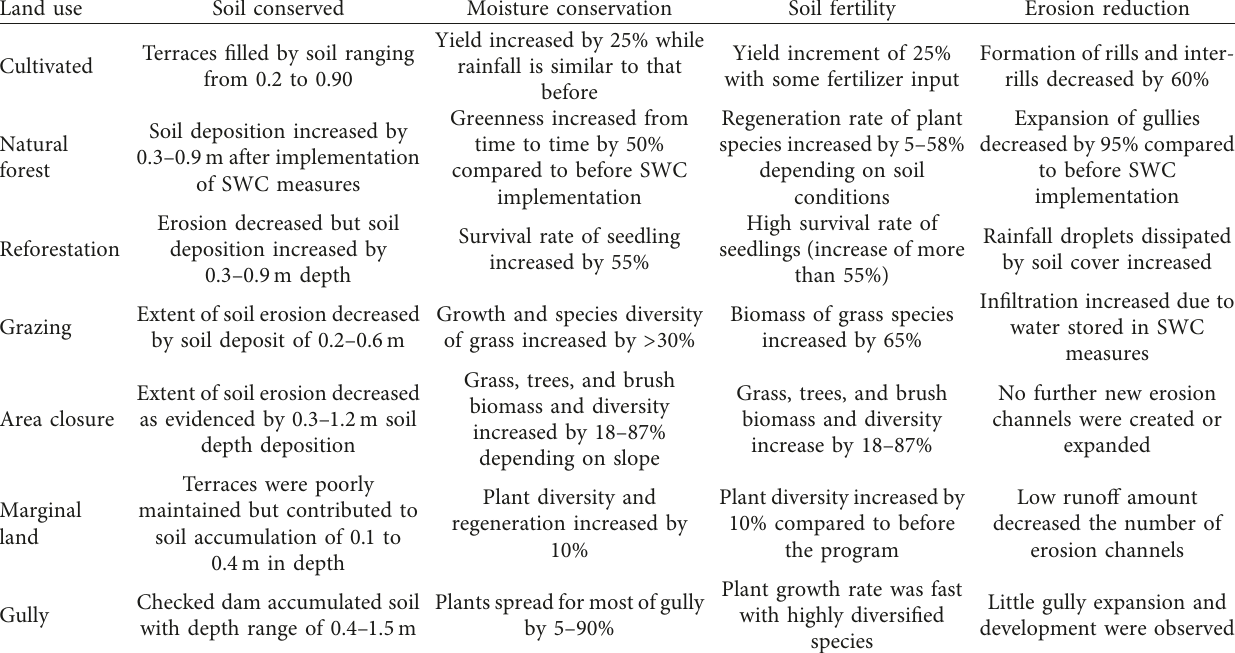
Table 5: Impacts of SWC measures on soil moisture, soil loss reduction, and soil fertility improvement (Kirubel M and Ghebreyesus Brhane,